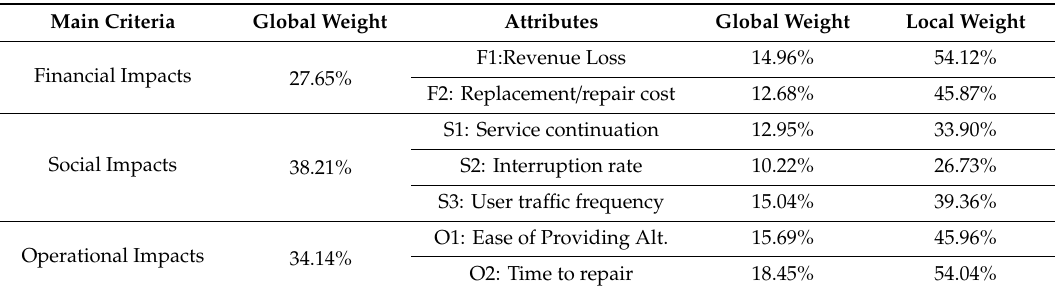
Figure 4. Failure impacts Local and Global Weights Plot. 3.1.3. Compute the Severity Scores (Ss i ) Scores for failure impacts criteria are obtained using actual metro statistics available online, literature review, and inspection reports. Due to the high variability in the selected attributes nature, all scores were individually normalized based on the highest score provided per network. This ensures the proportionality of the failure impacts calculations are specific to the studied segment in our case study. Table 3 identifies each failure impact, the attributes considered in the analysis and a detailed description of each attribute. The score of each attribute is normalized based upon the network under study and the maximum and minimum score thresholds identified. The maximum allowable number of interruptions per year is averaged from experts’ feedback in the questionnaire. Maximum time to repair is assumed to be 365 days, equivalent to one year, since the model analysis is done on an annual basis. User traffic frequencies for different stations are available online through reports and data published by the Subway transportation agency. Table 3. Failure impacts Definition and Scales. Failure Impact